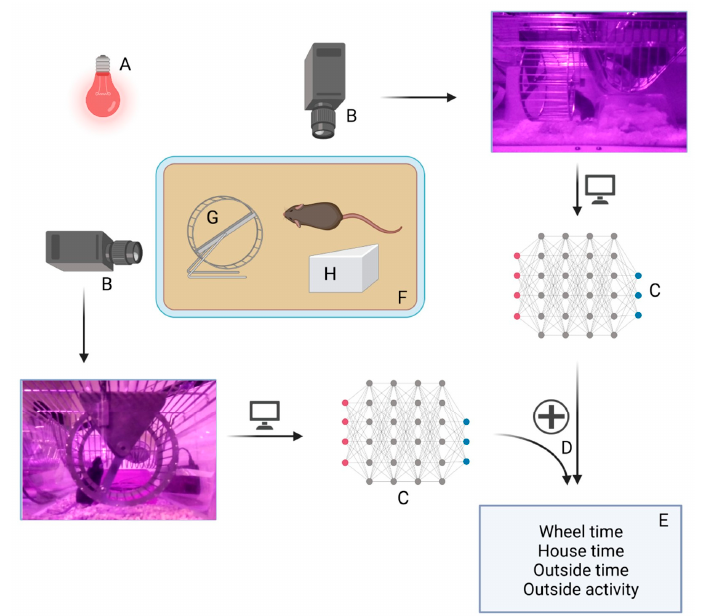
Figure 2. Overview of the different components of the Goblotrop system. Overview of the different components of the Goblotrop system. ( A ) infrared illumination, ( B ) infrared cameras from different perspectives, ( C ) neural networks, ( D ) fusing the output of the neural networks into parameters of interest, ( E ) parameter of interest, ( F ) cage of the mice, ( G ) running wheel, ( H ) house. Created with BioRender.com.